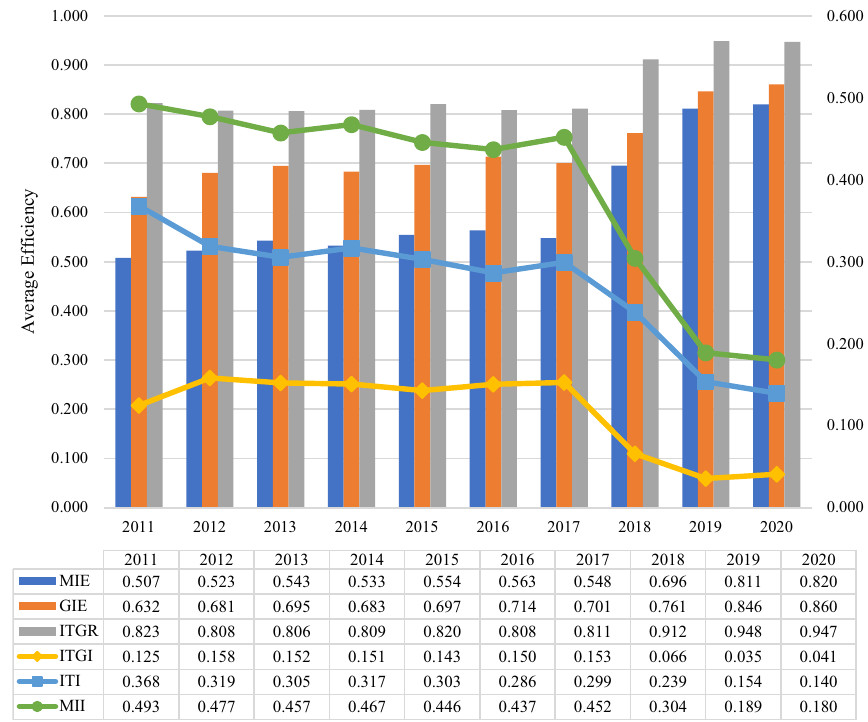
Fig. 3 The stack straight bar chart for average investment efficiencies and inefficiencies